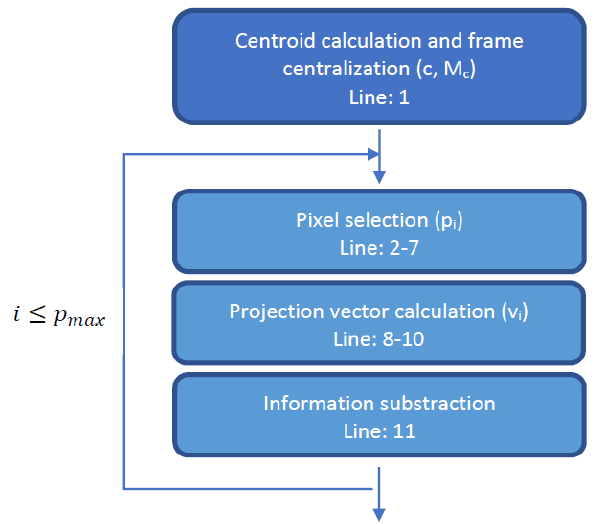
Figure 3. Flowchart of the HyperLCA